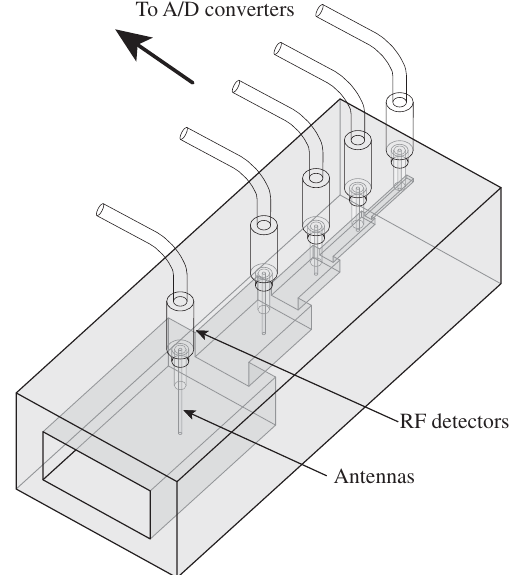
FIG. 6. Schematic representation of the microwave spectrome- ter.